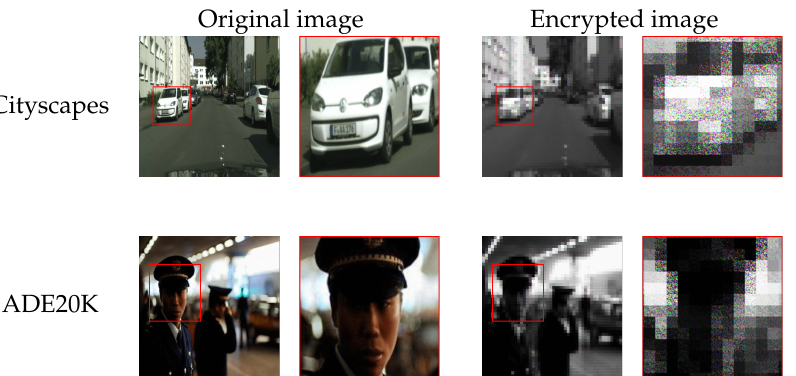
Figure 4. Example of encrypted images ( p × p = 16 × 16). Zoom-ins of red-framed regions are shown on right side of each image. The red boxes represent sensitive information such as license